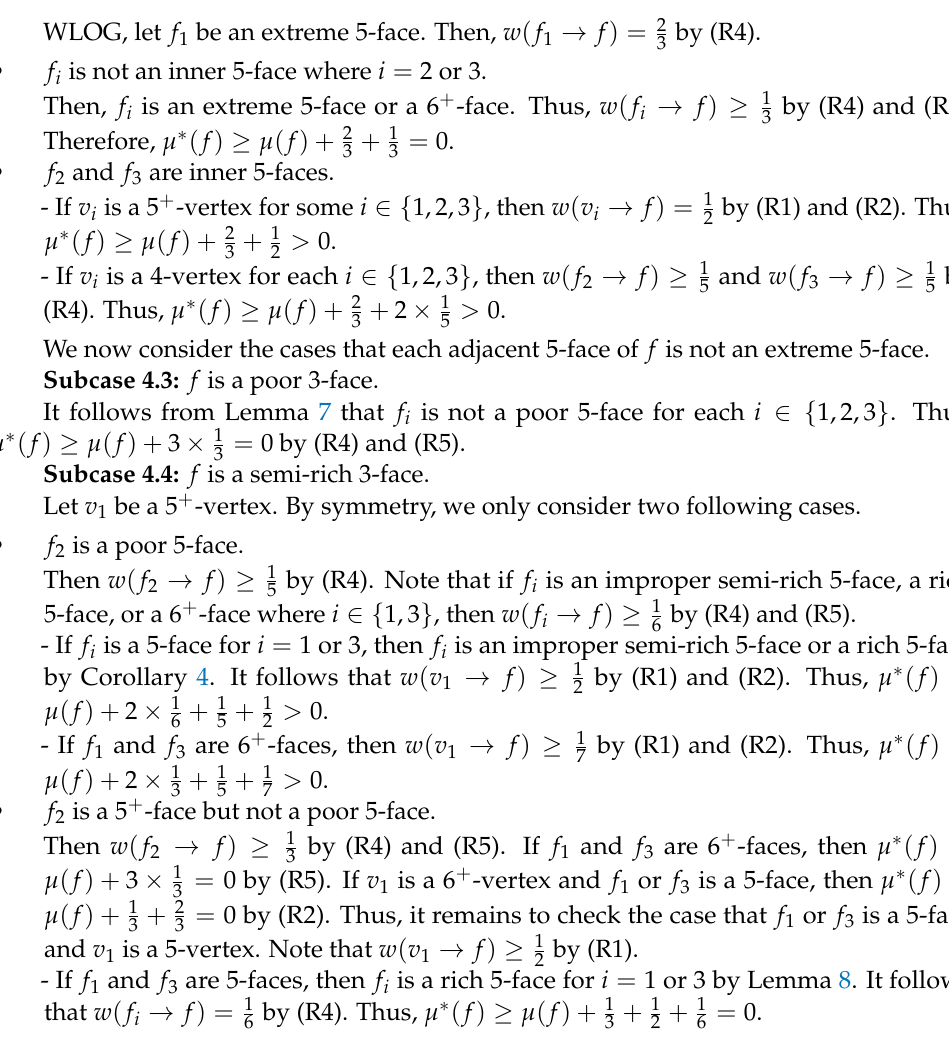
Figure 1. The configuration in CASE